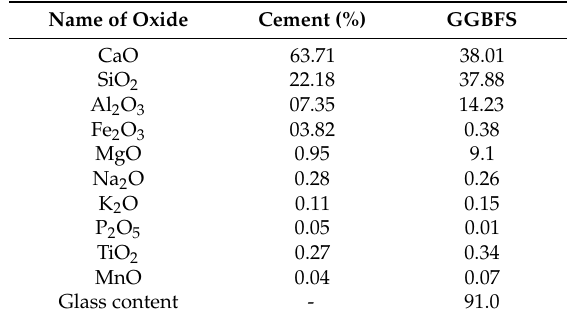
Table 2. Chemical properties of the cement and ground granulated blast furnace slag